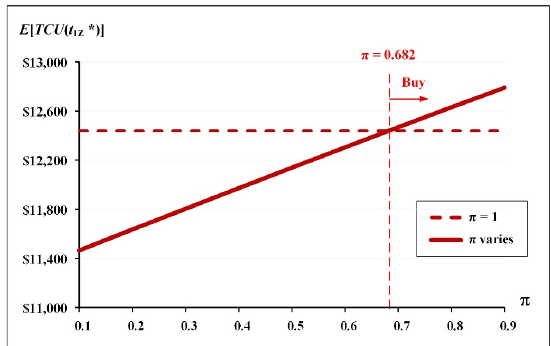
Fig. 15. The explorative result from comparing this study’s utilization with existing studies